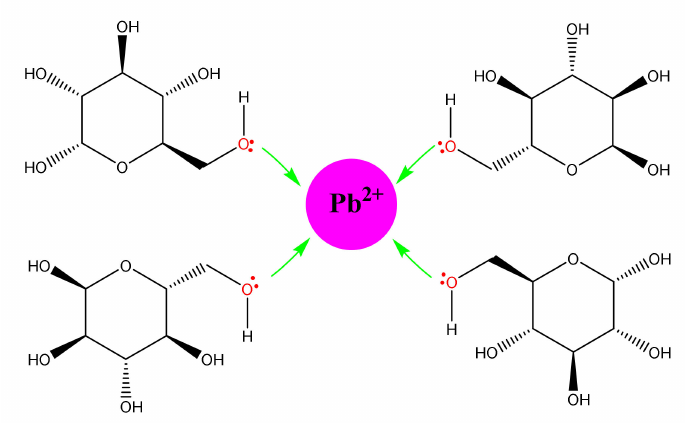
Figure 8. Pb 2+ adsorption mechanism of modified cassava starch. Reprinted with permission from reference [134], Copyright 2021